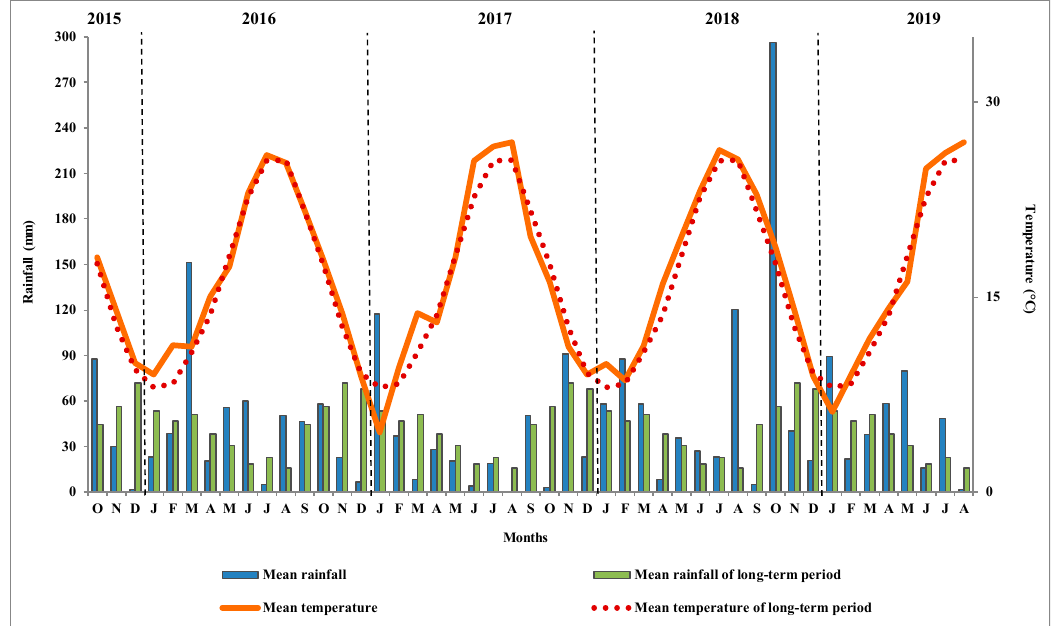
Figure 1. Mean monthly temperatures and rainfall during experiment (2015–2019) in comparison with the long-term (1981–2018) averages.